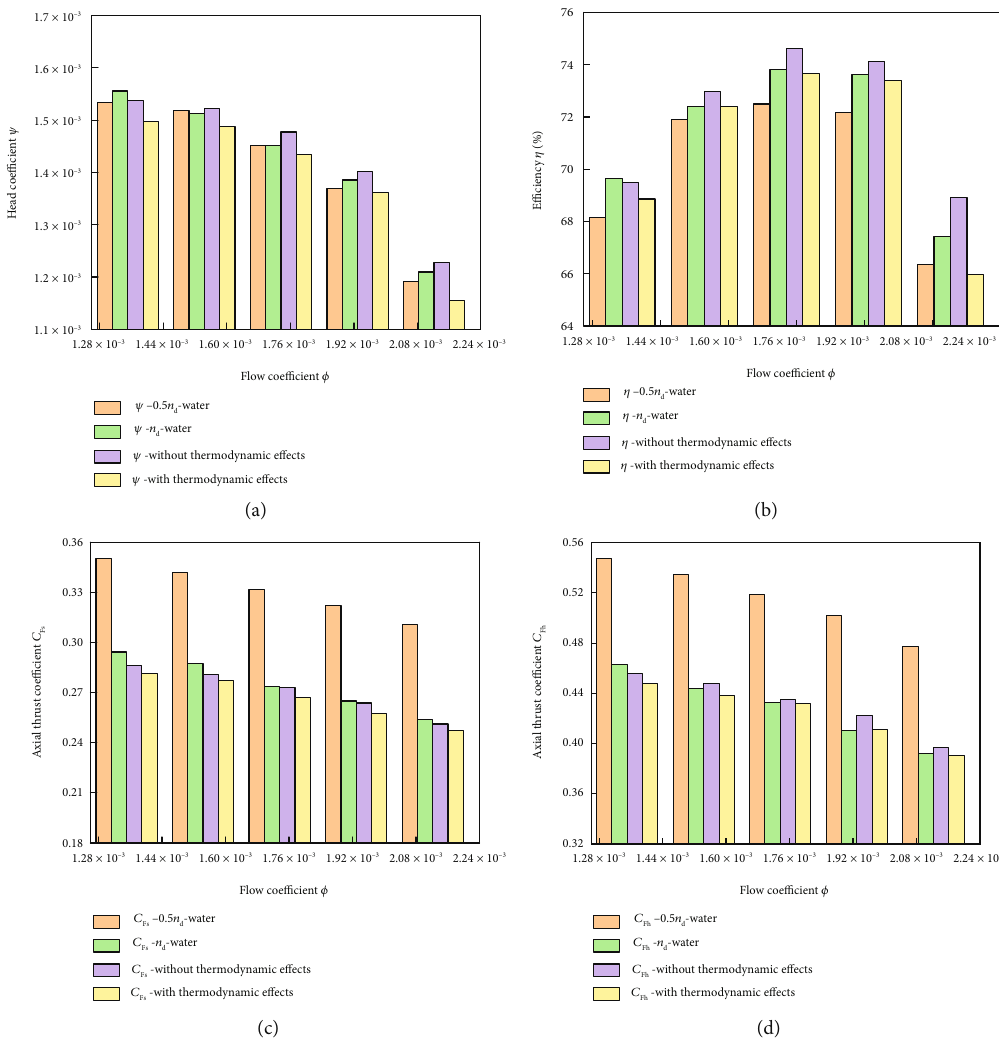
Figure 11: Comparison of the performance with and without thermodynamic e ff ects. (a) Head coe ffi cient, (b) e ffi ciency, (c) axial thrust coe ffi cient C Fs , and (d) axial thrust coe ffi cient C Fh Figure 10(a), the head coe ffi cients vary from 1 : 45 × 10 − 3 to 1 : 48 × 10 − 3 at rated fl ow, and the turbopump e ffi ciencies